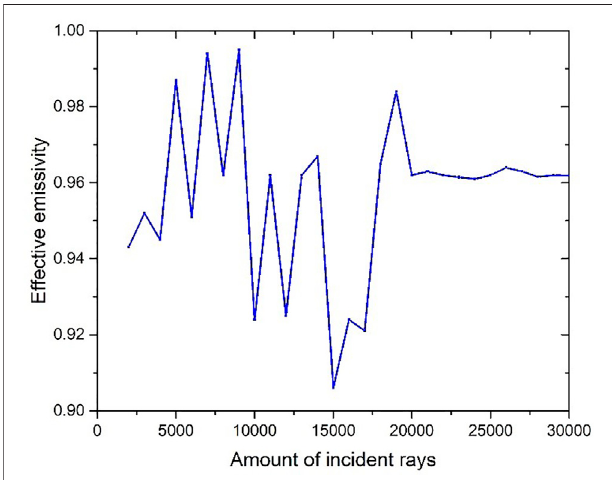
FIGURE 5 | Emissivity stability varies with the amount of incident rays.